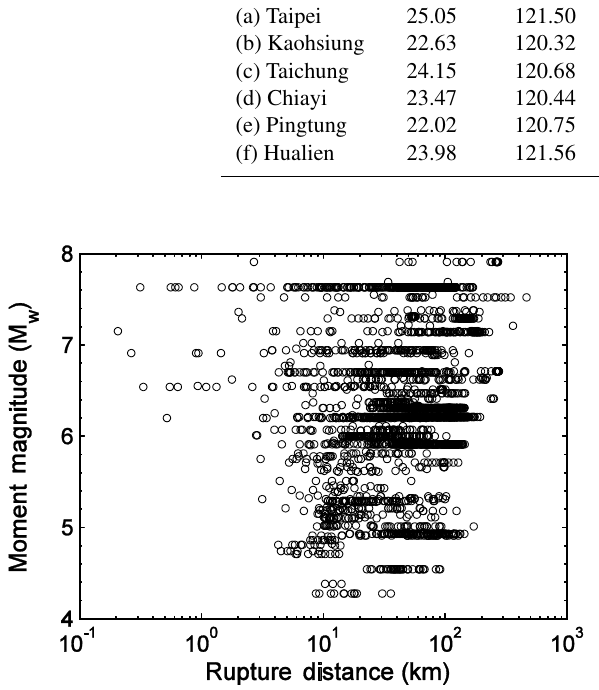
Figure 5. Moment magnitude and rupture distance distribution for PEER NGA records used in this